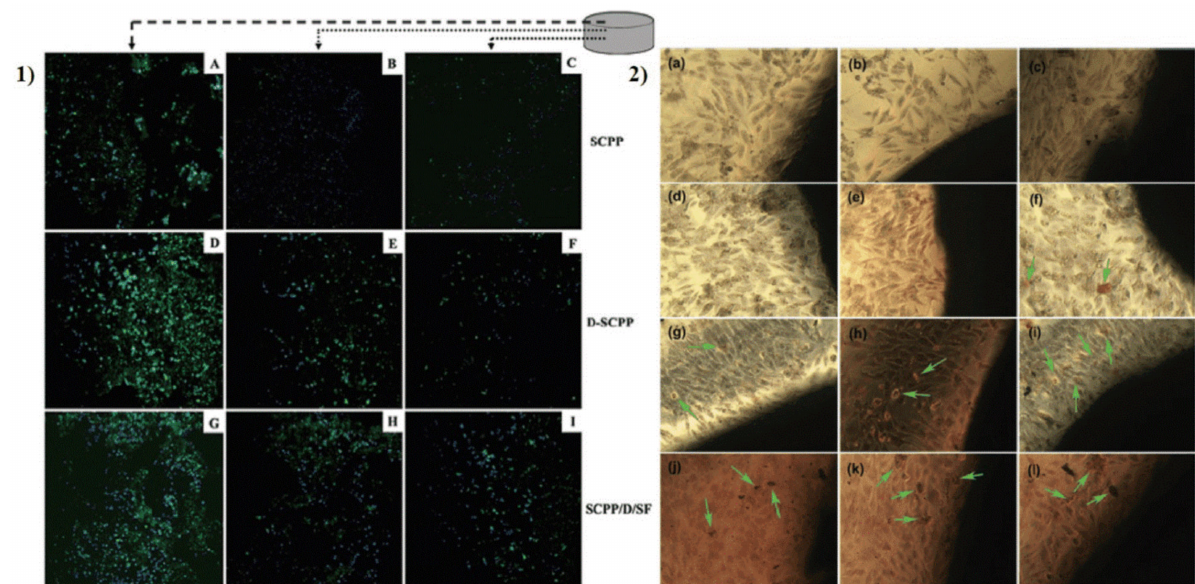
Figure 3. Image ( 1 ) represents cells cultured with different scaffolds. Image ( 2 ) shows scaffolds alizarin red staining on day 4 ( a – c ), day 7 ( d – f ), day 10 ( g – i ), day 14 ( j – l ); SCPP ( a , d , g , j ), D-SCPP ( b , e , h , k ), SCPP/D/SF ( c , f , i , l ), respectively. Green arrows: calcium nodules. Courtesy of: Wang X, Gu Z, Jiang B, Li L, Yu X. Surface modification of strontium-doped porous